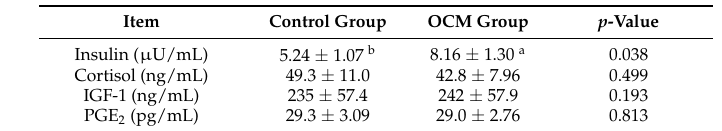
Table 2. Effects of dietary supplementation with OCM (50 mg/kg diet) on the concentrations of hormones, IGF-1 and PGE 2 in